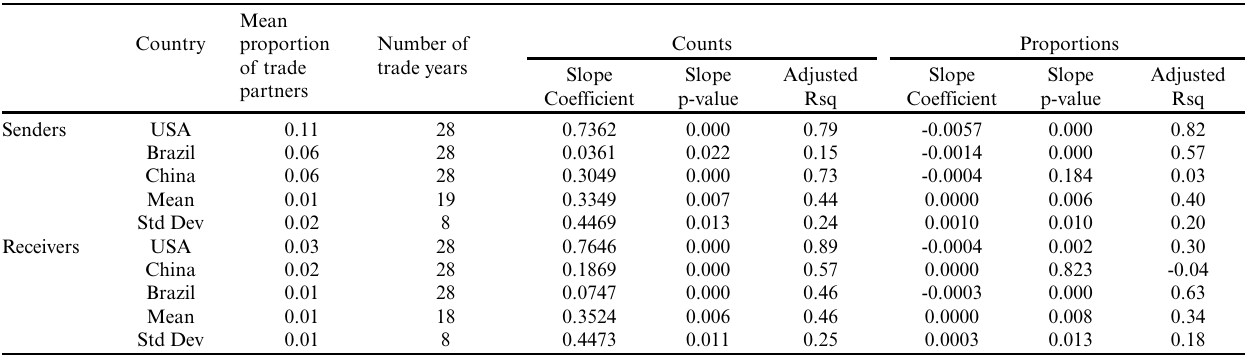
Table 1 . Linear regressions of trade partnerships for key countries in terms of raw counts of sending (exporting) and receiving (importing) partners and proportions of total trade partners per year. The analysis was limited to countries that traded at least four times with another country for the period